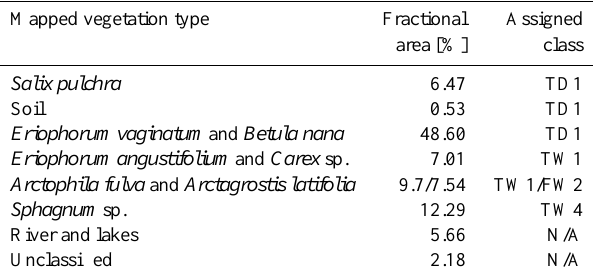
Table 1. Vegetation classification and fractional area. Mapped vegetation